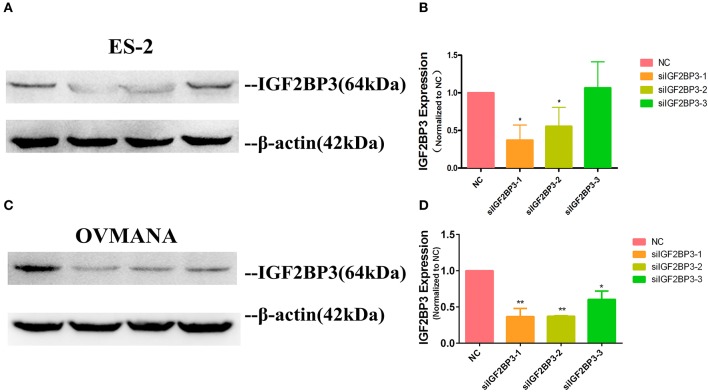
The expression level of IGF2BP3 after transfection with siRNAs. (A;
Supplementary Figures 3A–C; C;
Supplementary Figures 3D–F) IGF2BP3 protein expression after exposure to NC, siIGF2BP3-1/2/3 were verified by Western blotting in both ES2 and OVMANA cell lines. (B,D) Both siIGF2BP3-1 and -2 remarkably reduced IGF2BP3 expression, while -3 was not as significant as siIGF2BP3-1 and -2.*P < 0.05, **P < 0.01 compared with NC.